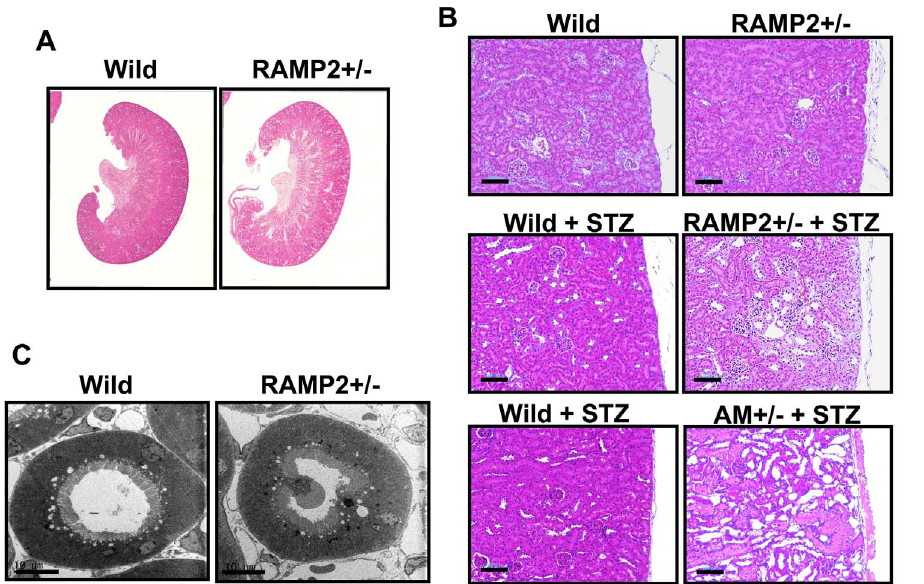
Figure 2. Renal tubular changes induced by the STZ treatment. (A) Cross-sections of kidneys collected from wild-type and RAMP2 + / 2 mice 4 weeks after STZ administration (H & E staining). (B) Higher magnification of the renal cortex. STZ-administered RAMP2 + / 2 and AM + / 2 showed substantial degeneration of tubule cells, which was not detected in RAMP2 + / 2 without STZ administration. (C) Electron micrograph of a section of proximal tubule shows destruction of the brush border (protrusion of a tubule cellular membrane into the lumen) in a RAMP2 + / 2 kidney. Scale bars=100 m m (B), 10 m m (C).